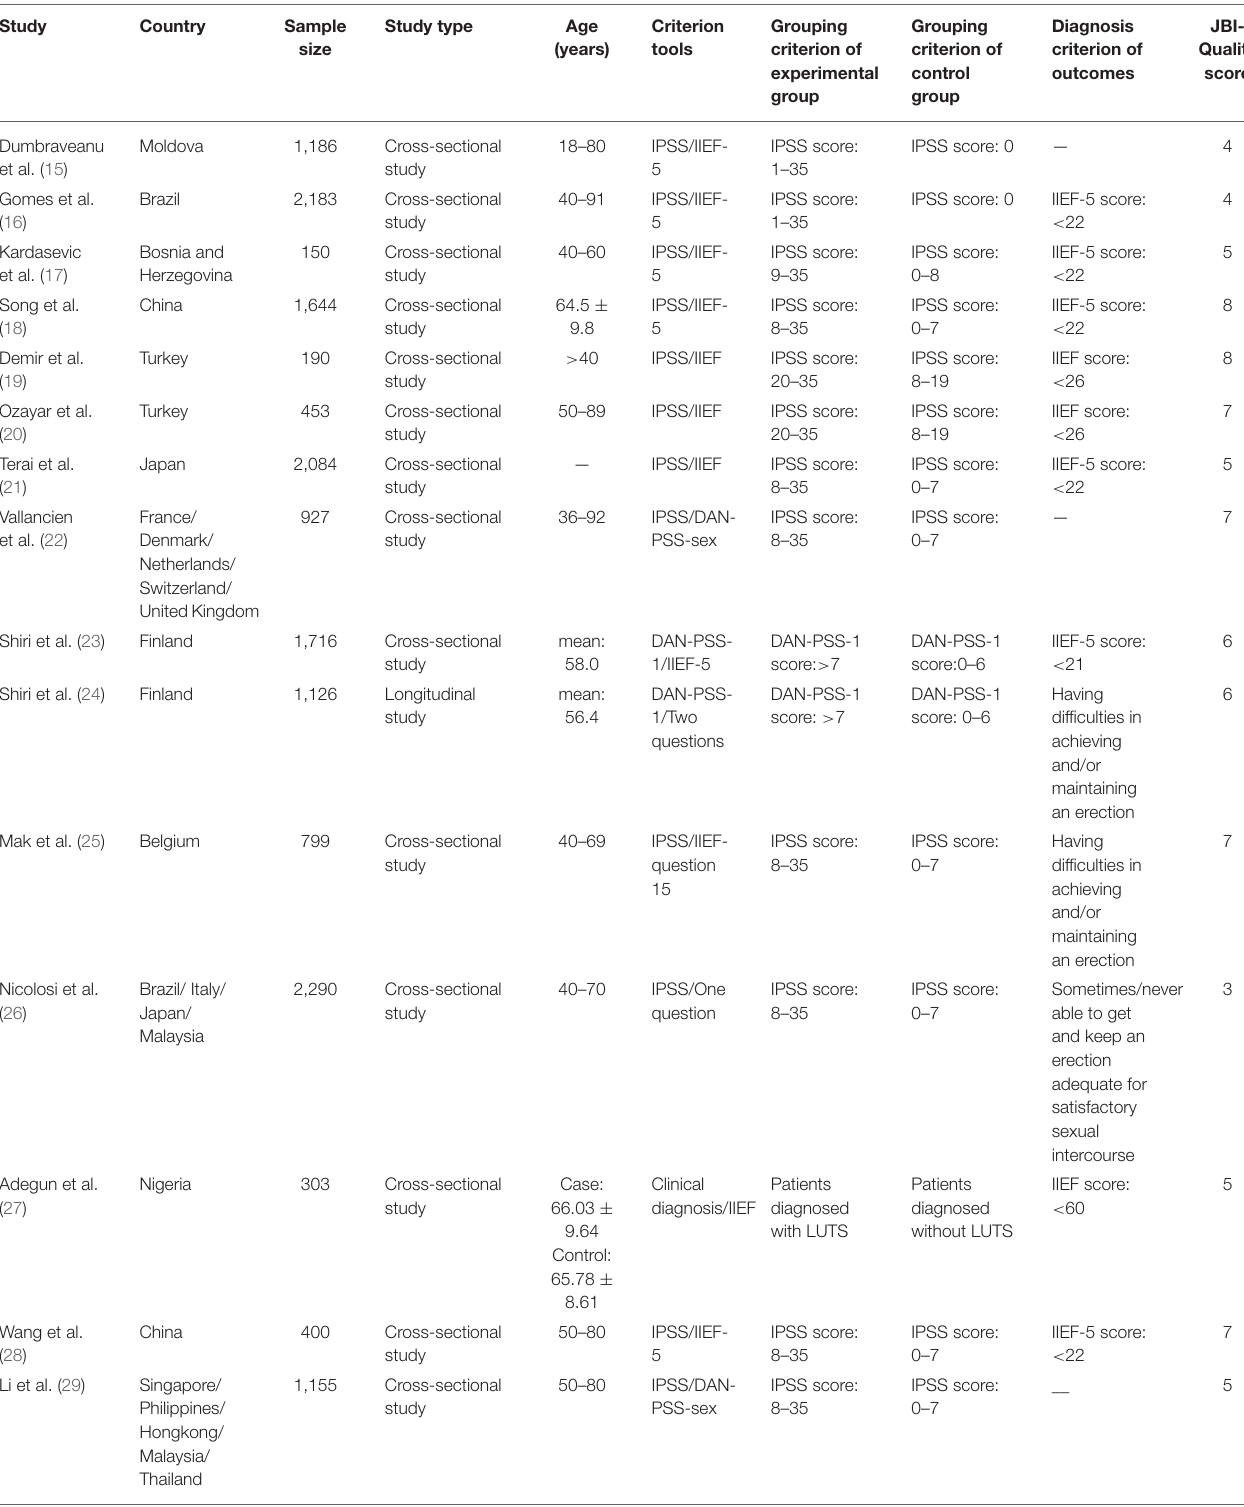
TABLE 1 | Clinical and demographic characteristics of included